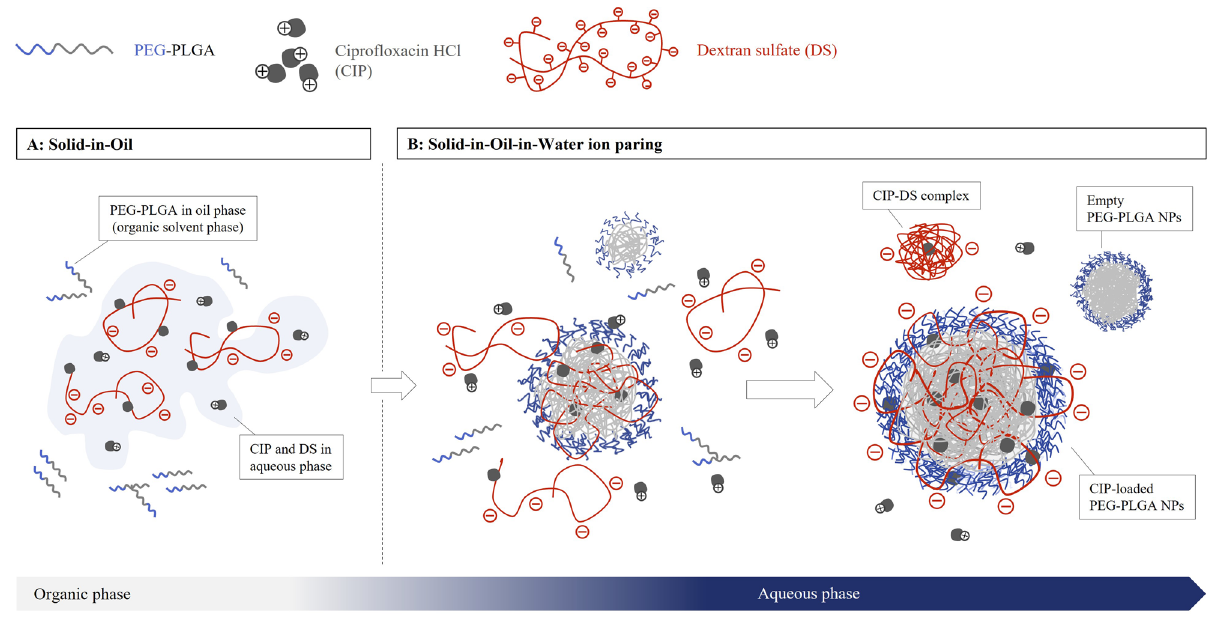
Figure 2. Illustration of CIP-loaded PEG–PLGA NP formation via the S/O/W ion paring process (created from Microsoft 365 PowerPoint version 2211, www. micro soft. com), solid-in-oil (S/O) process ( A ); CIP was added into the PEG–PLGA suspension in acetone, followed by the dextran sulfate solution. S/O/W process ( B ); the mixture ( A ) was poured into distilled water to form nanoparticles via a self-assembly